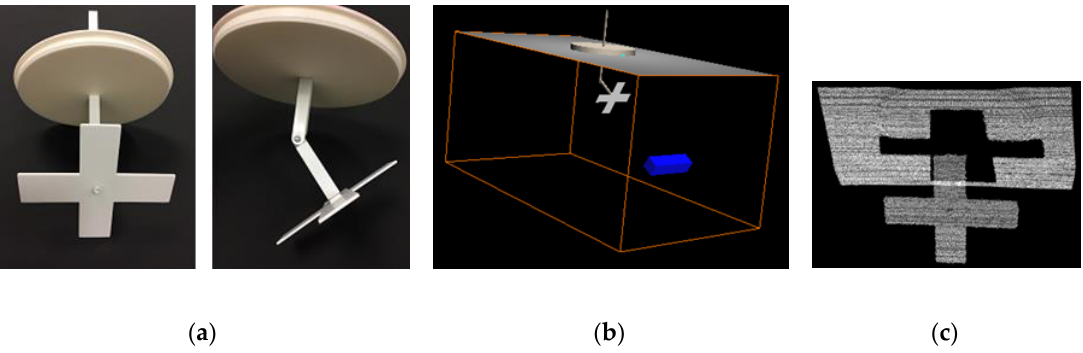
Figure 4. ( a ) The cross-shaped reference object; ( b ) Schematic visualization of the cross-shaped reference object, as installed in the Wavelia examination table, for camera calibration; ( c ) The point cloud corresponding to the cross-shaped reference object as seen by the camera at 0°.